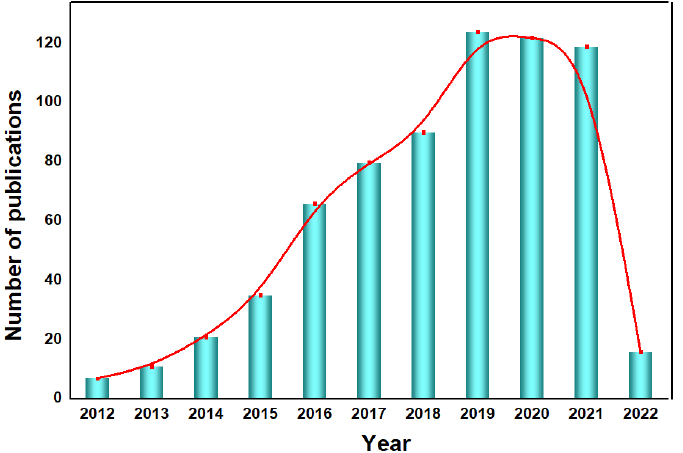
Figure 1. Year-by-year publications of g − CN research on PEC devices, the keywords were set to [“graphitic carbon nitride” and “photoelectrochemical”] (The red line is the trend line). Data are obtained from the ISI Web of Science, dated 17 April 2022.